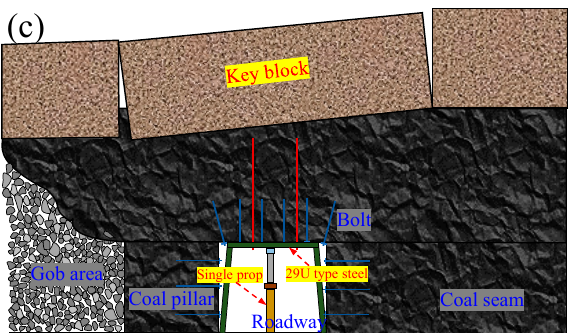
Figure 23. Support diagram of coal pillar rib: ( a ) filling support on the side of the goaf, ( b ) concrete wall support on the side of the roadway, and ( c ) general bolt and anchor cable support. ( a , b ) [31,32] and ( c ) [94,95].